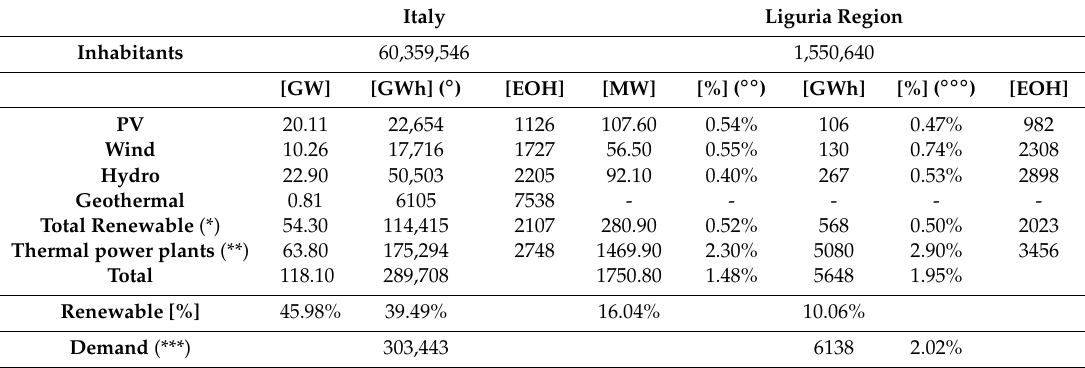
Table 1. Italy and Liguria region electricity